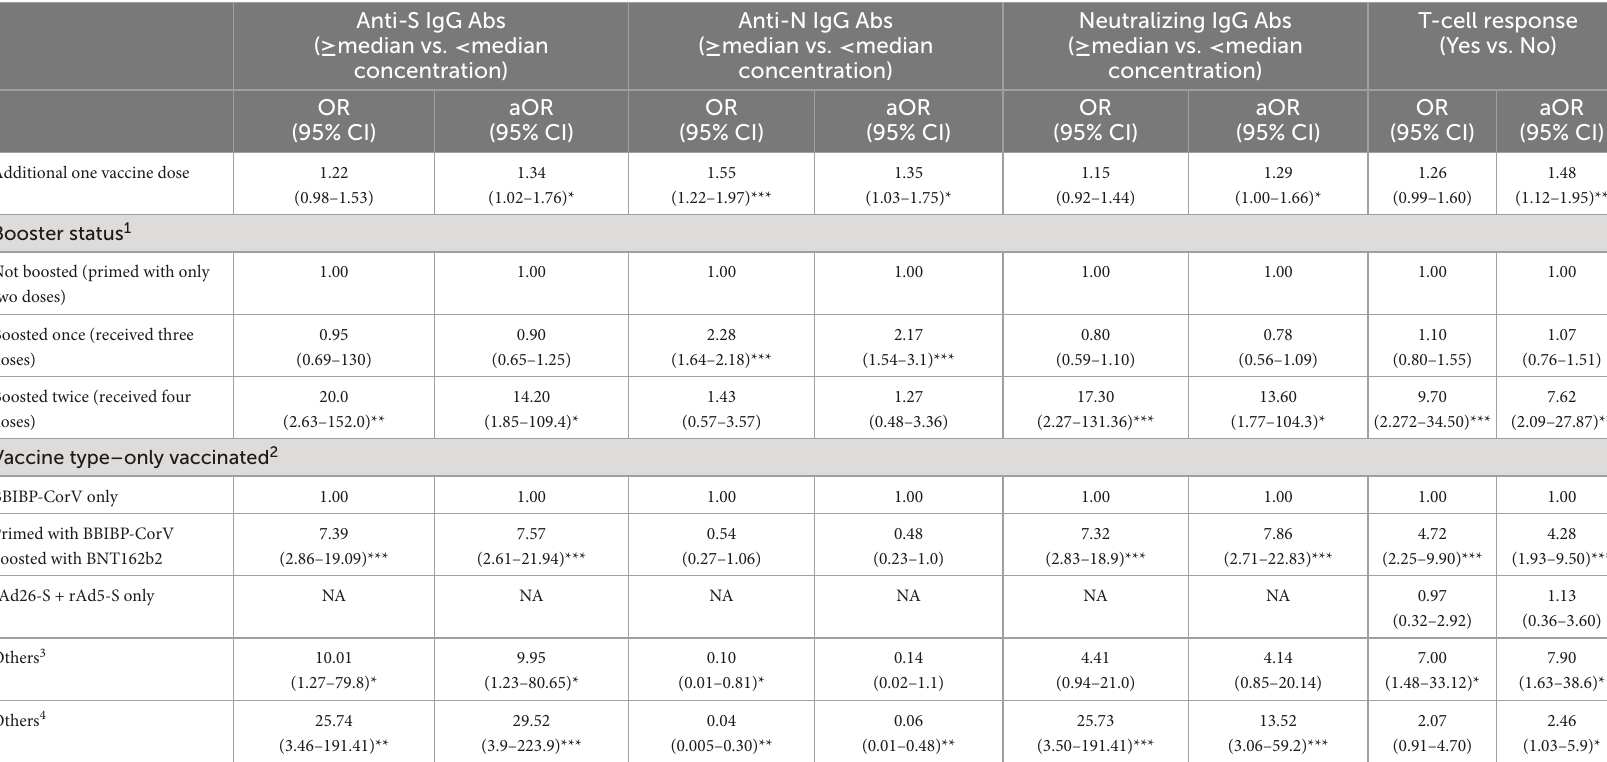
TABLE 4 Crude (OR) and adjusted odds ratio (aOR) of the association between every dose increase in number of anti-SARS-CoV-2 vaccine doses and boosting status with having ≥ median concentration of anti-S IgG ( ≥ 357.5 BAU/ml), anti-N IgG ( ≥ 146.5 COI), and neutralizing IgG ( ≥ 172.0 AU/ml) antibodies and having a T-cell response. Anti-S IgG Abs ( ≥ median vs. <